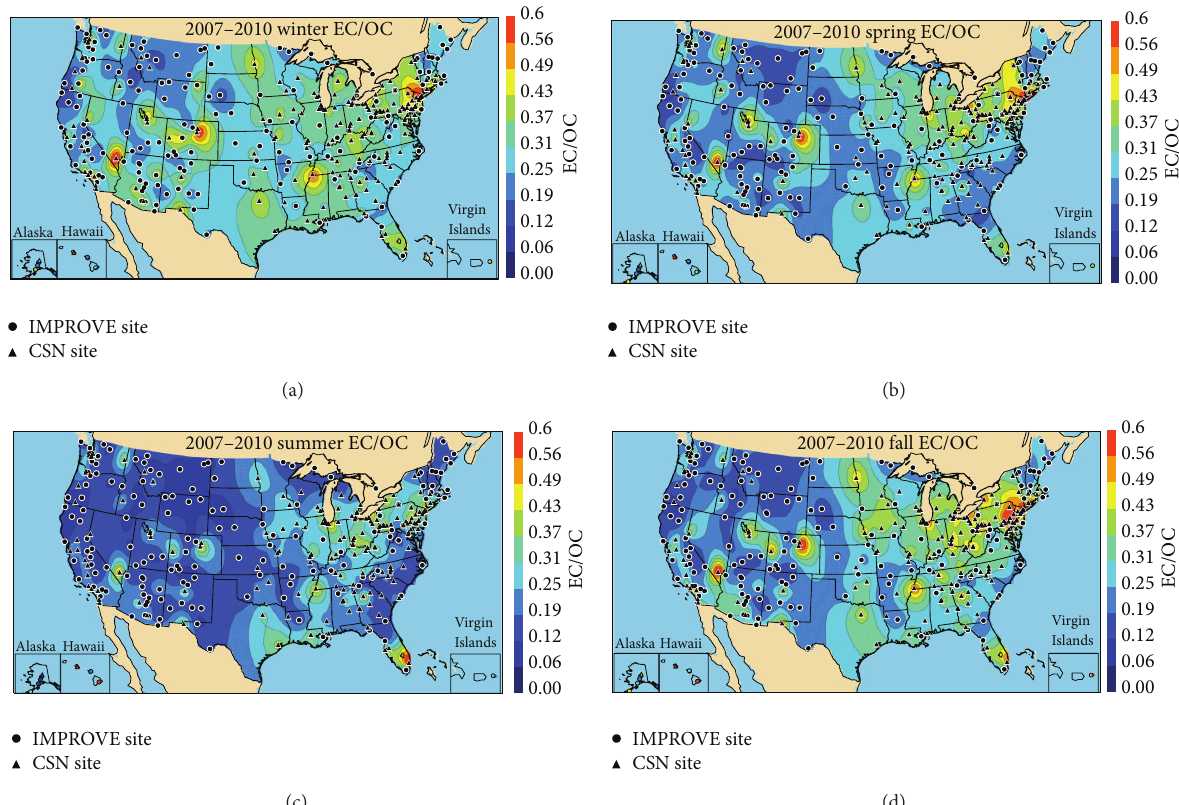
Figure 7: IMPROVE and CSN 2007–2010 seasonal mean PM 2.5 elemental carbon (EC) to organic carbon (OC) ratios for (a) winter (DJF), (b) spring (MAM), (c) summer (JJA), and (d) fall (SON). IMPROVE sites are shown as circles, and CSN sites are shown as